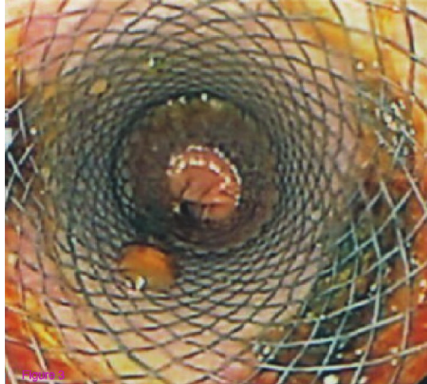
Figure 3: Endoscopic view of the placement of the stent.